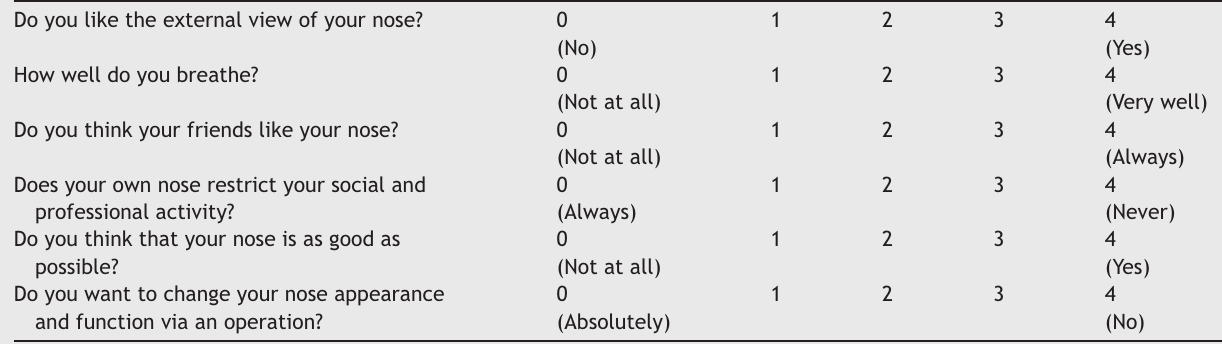
Rhinoplasty Outcome Evaluation (ROE) questionnaire.